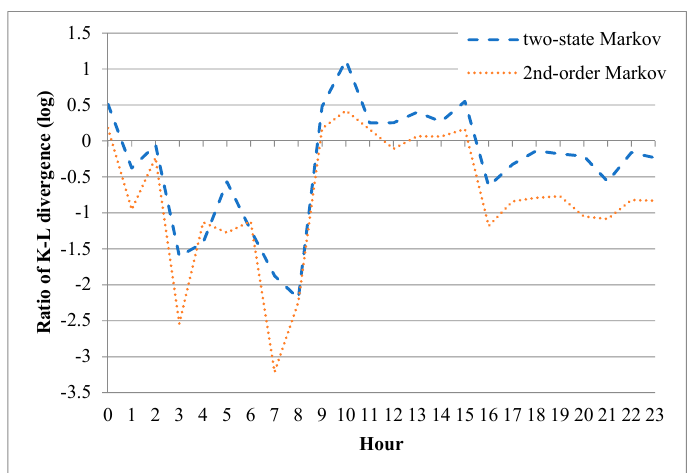
Figure 17. K-L divergence ratios of Markov error models for correct-frame bursts in each hour of the experimental period.